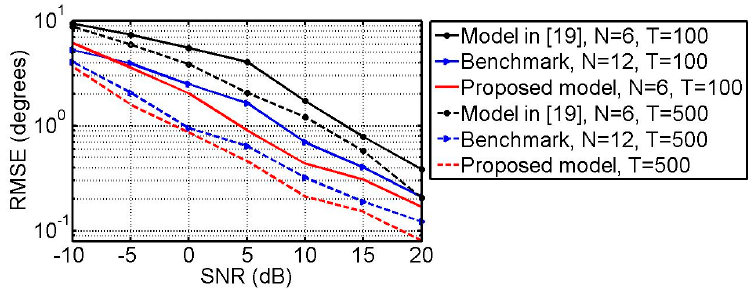
Figure 6. RMSE of the DOA estimates versus SNR with T = 100 and T = 500.